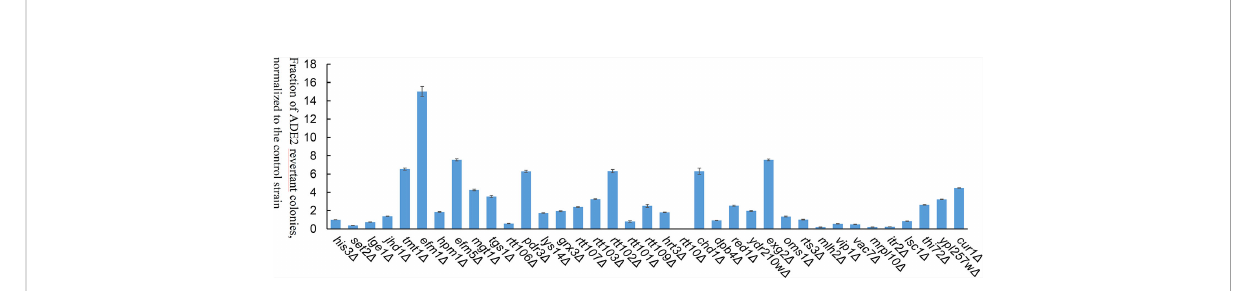
FIGURE 5 Transposition ef fi ciency of Ppmar2NA in 36 yeast single-gene mutants. The mean excision frequency of Ppmar2NA in the 36 yeast mutants was normalized to that of the control strain ( His3 D ). Y-axis represents the fraction of ADE2 revertant colonies, normalized to the control strain. Each excision assay was conducted with six biological replicates.